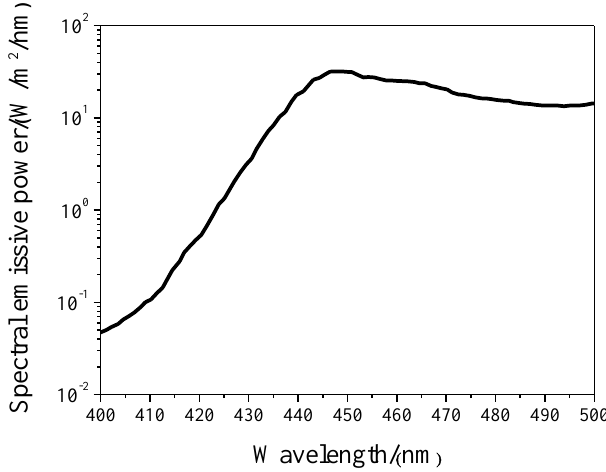
Figure A2. The spectral absorption coefficient of water [20].